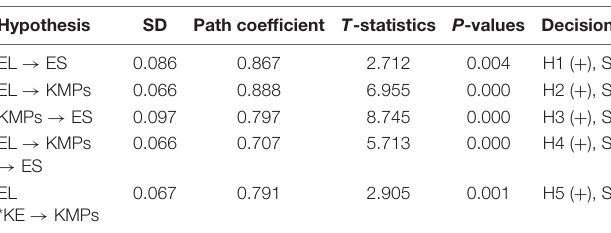
TABLE 4 | Finding from SEM (full